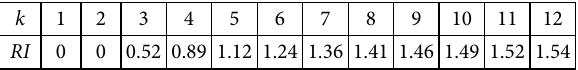
Table 2. Pair-wise comparison matrix for similar units